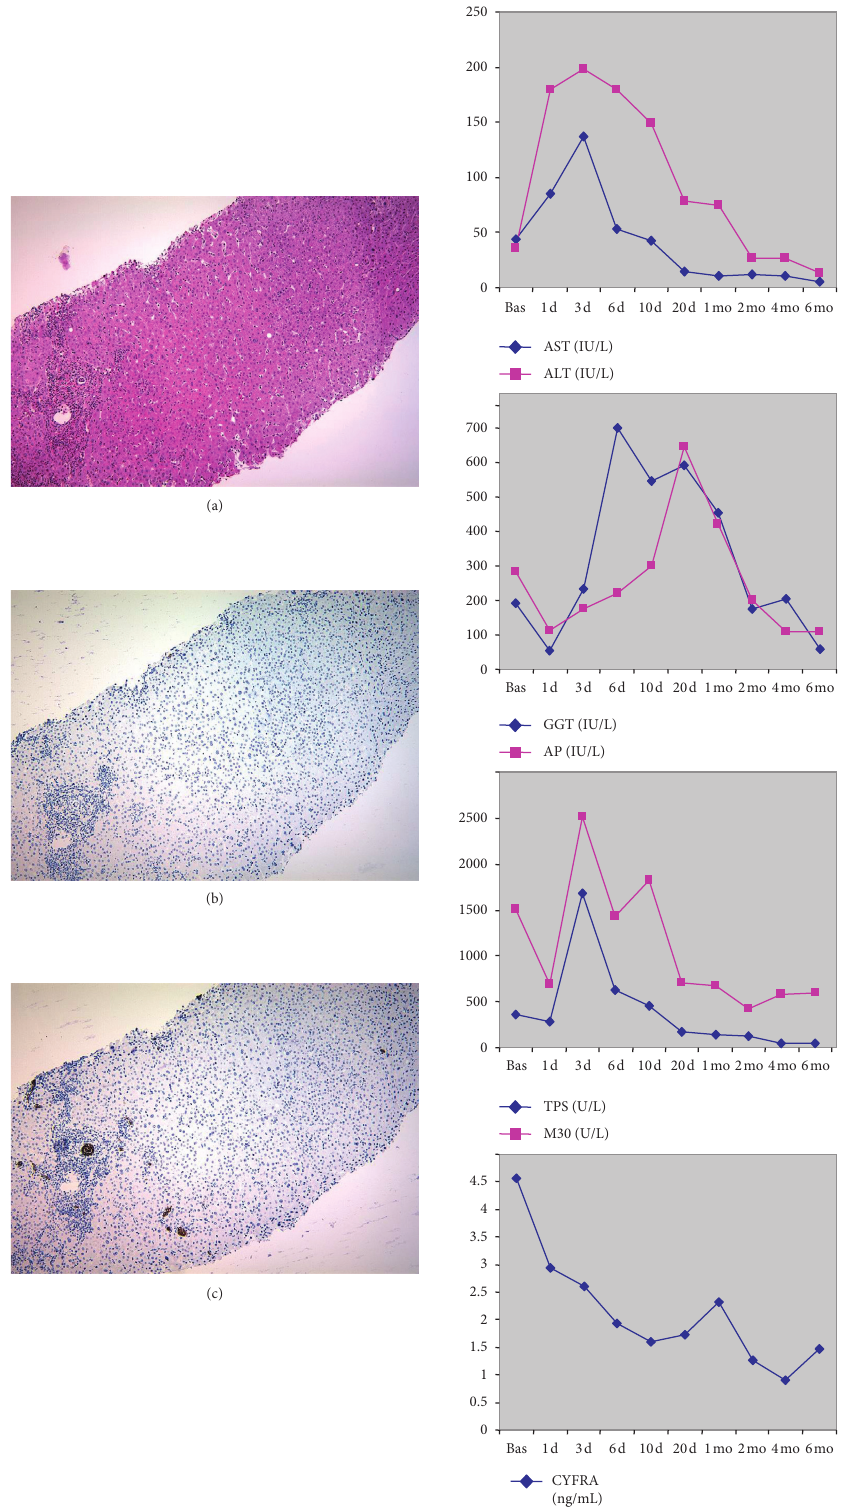
Figure 5: Individual data from Patient 4, who had acute cellular rejection after liver transplantation. Liver biopsy (left panels) was performed on day 33 after transplantation. (a) Hematoxylin-eosin stain revealed typical signs of rejection. (b) Immunostaining for the M30 neoepitope was negative. (c) Immunostaining for K19 revealed the normal positivity in the bile ducts and in a few scattered hepatocytes. Time-course changes in standard biochemical markers (AST, ALT, GGT, and alkaline phosphatase (AP)) and serum keratins (TPS, M30, and CYFRA 21-1) are presented in the right panels. d, day; mo,